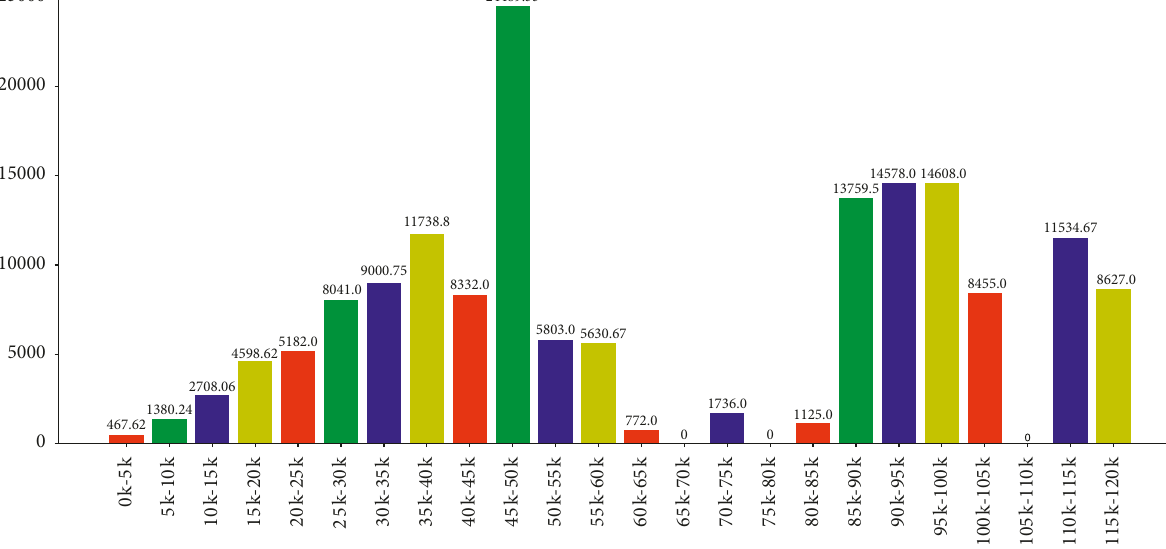
Figure 8: Statistical chart of the number of newly added companies three years after the opening of railway stations in three years. The abscissa indicates the number before completion of the railway, and the ordinate indicates the average number of the newly added company after 3 years of